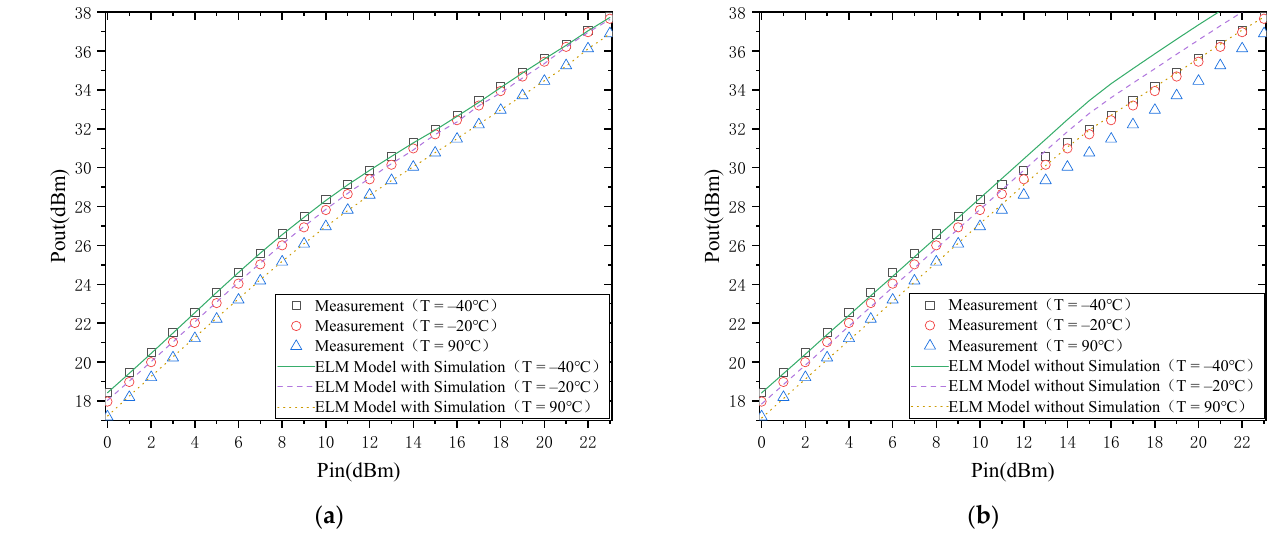
Figure 6. Output power: ( a ) with simulation; ( b ) without simulation.